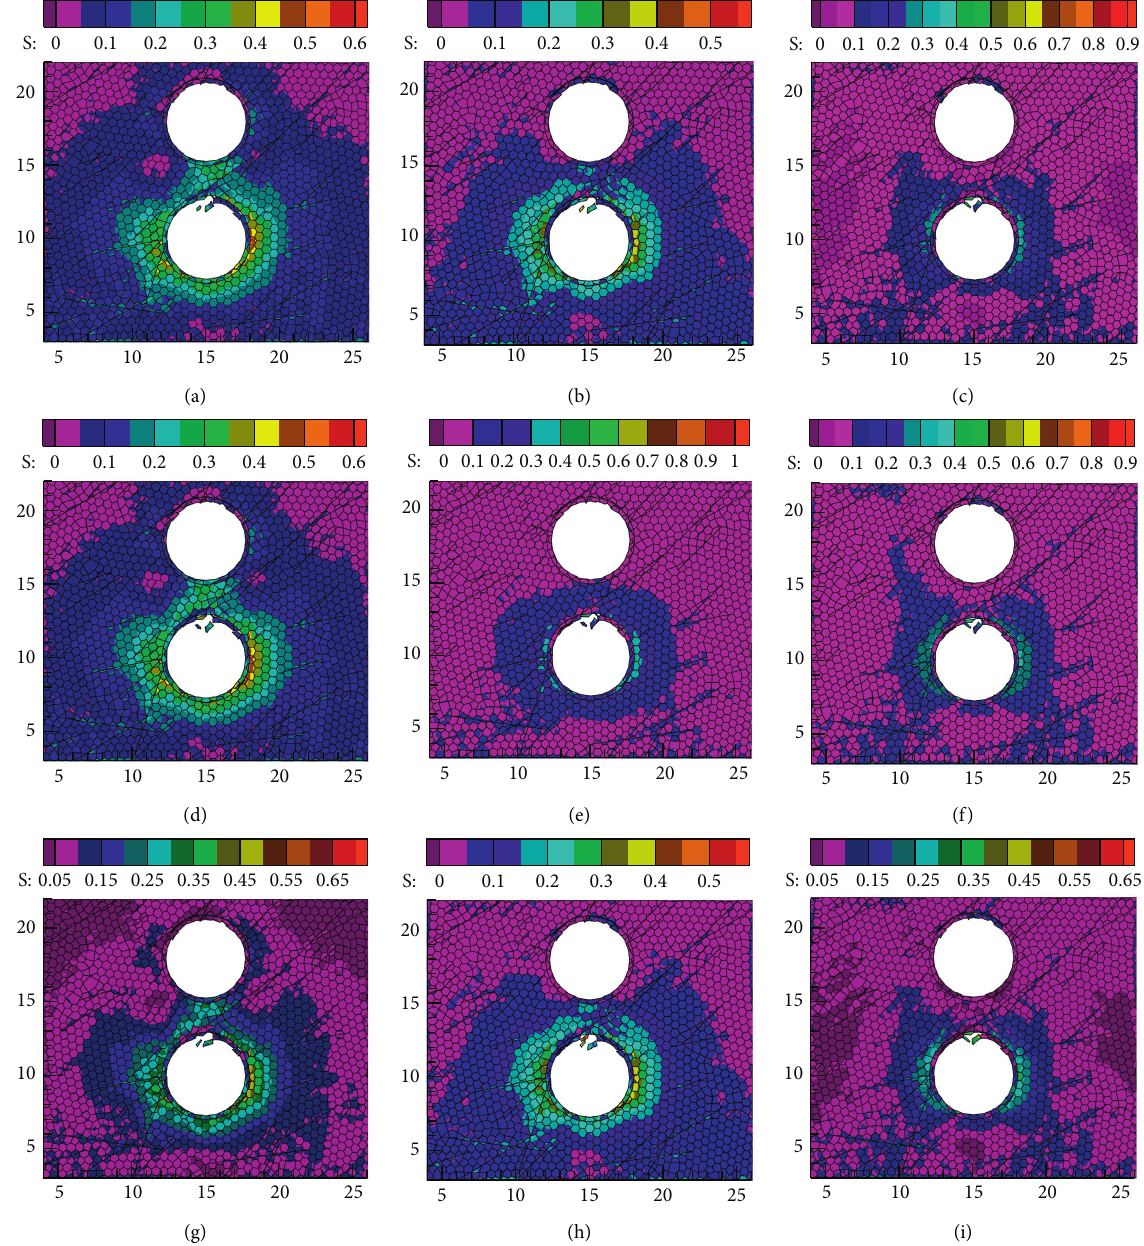
Figure 9: Principal stress difference distribution of